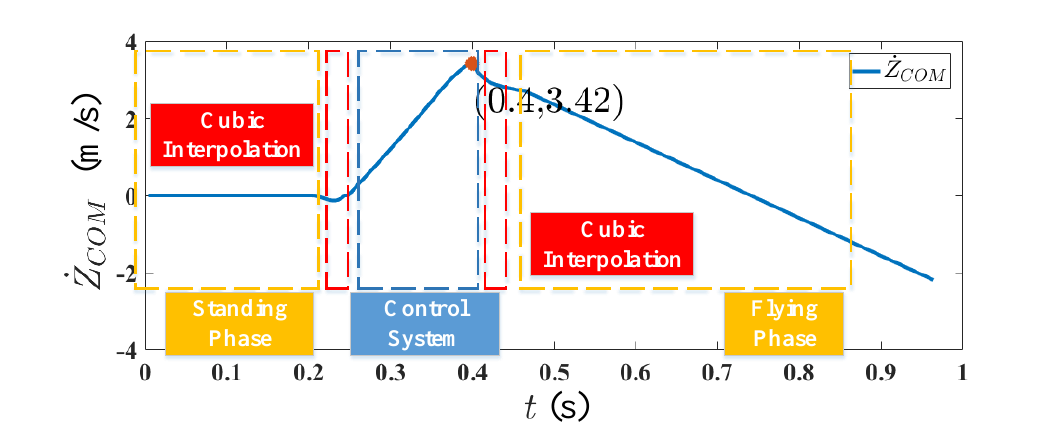
Figure 13. The velocity of COM (center of mass) during the simulation.